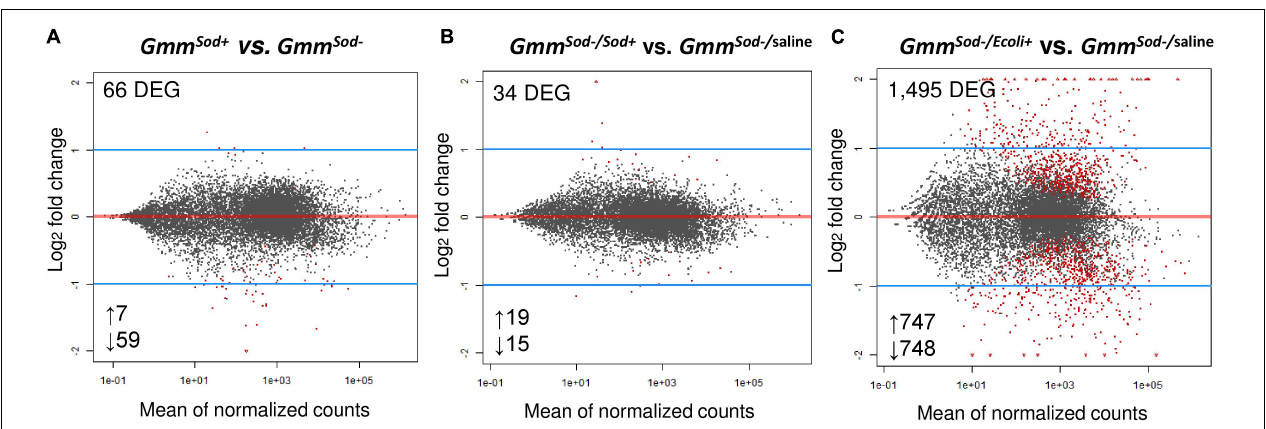
FIGURE 2 | Differentially gene expression patterns obtained by RNA-seq analysis between the tsetse fly groups. (A) Comparison of 10-days old symbiotic ( Gmm Sod + ) versus S. glossinidius -free ( Gmm Sod − ) flies. (B) Comparison of Gmm Sod − flies exposed to 10 6 CFU Sodalis glossinidius ( Gmm Sod − / Sod + ) versus the corresponding injection-control with sterile saline ( Gmm Sod − / saline ). (C) Comparison of Gmm Sod − flies exposed to 10 5 CFU E. coli ( Gmm Sod − / Ecoli + ) versus Gmm Sod − / saline . Bacterial exposure was performed on day 8 post-eclosion via intrathoracic microinjection as well as per os and total RNA was extracted after 48 h. Each dot represents the mean of expression (normalized counts) for a given gene. Significantly differentially expressed genes (DEG) were defined by a p -value < 0.05 and a false discovery rate (FDR; Benjamini-Hochberg) < 10% and are shown in red. Numbers below the plots refer to the amount of up-and downregulated